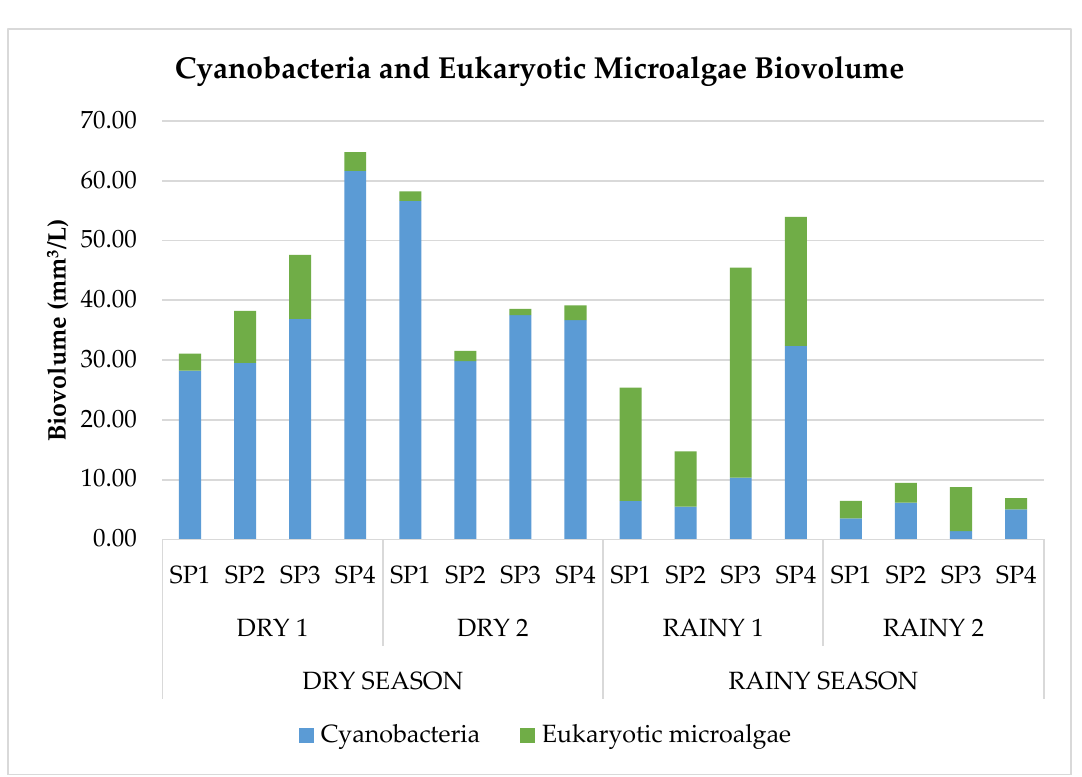
Figure 3. Cyanobacteria vs. eukaryotic microalgae biovolume.